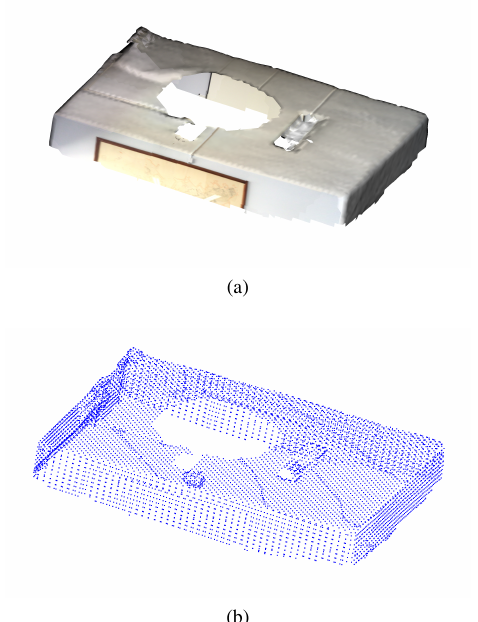
Figure 2: Example of the 3D model of a room ceiling acquired with the Structure Sensor: (a) 3D model with texture, (b) 3D point cloud of the room, ready for the RANSAC plane